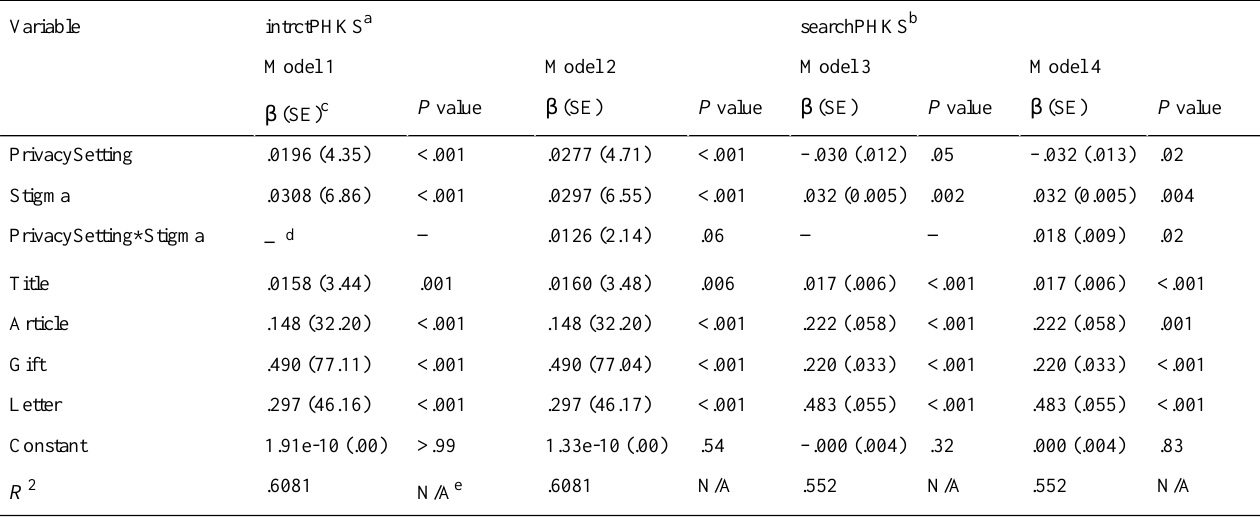
Table 5. Results of the robust check using cross-section data (N=23,112 for all